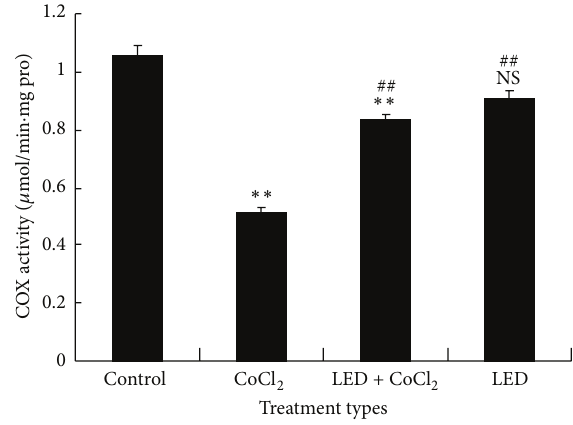
Figure 3: Effect of 21mW/cm 2 670 nm LED treatment on cy- tochrome C oxidase activity. Data are means ± SEM. ∗∗ 𝑃 < 0.01 indicates comparison with control group. NS indicates no significance compared with control group. ## 𝑃 < 0.01 indicates comparison with 200 𝜇 mol/L CoCl 2 group.